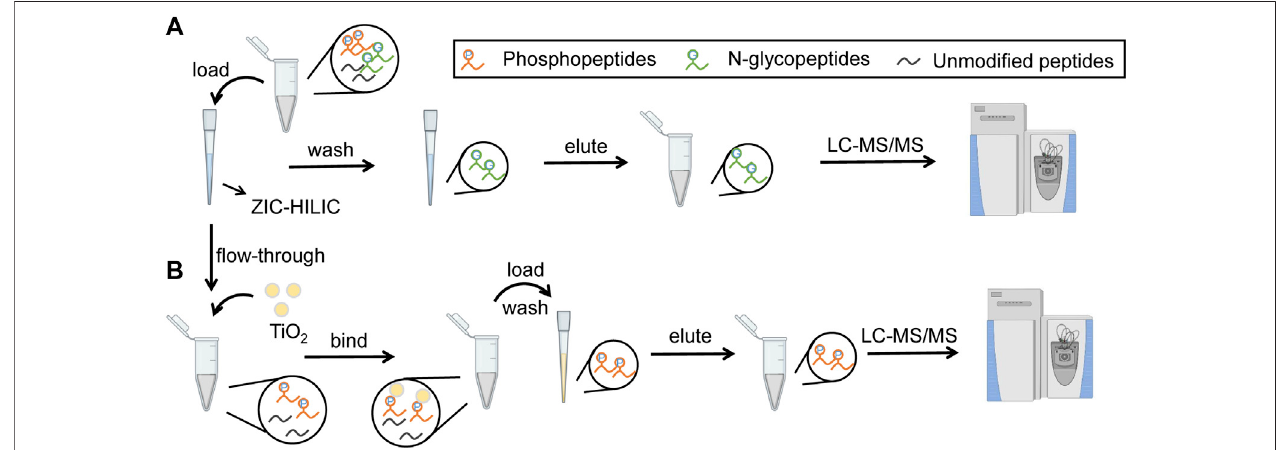
FIGURE 1 | Work fl ow of tandem enrichment of N-glycopeptides and phosphopeptides. (A) enrichment of N-glycopeptides. (B) enrichment of